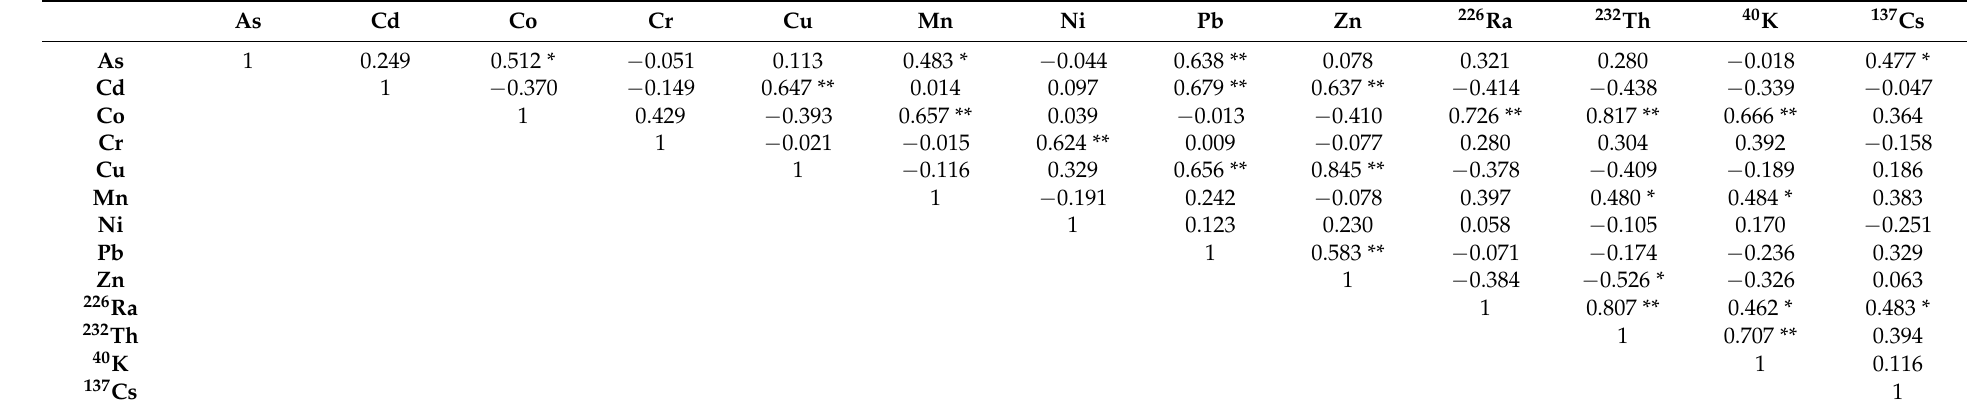
Table 5. Spearman correlation matrix of heavy metals and radionuclides in